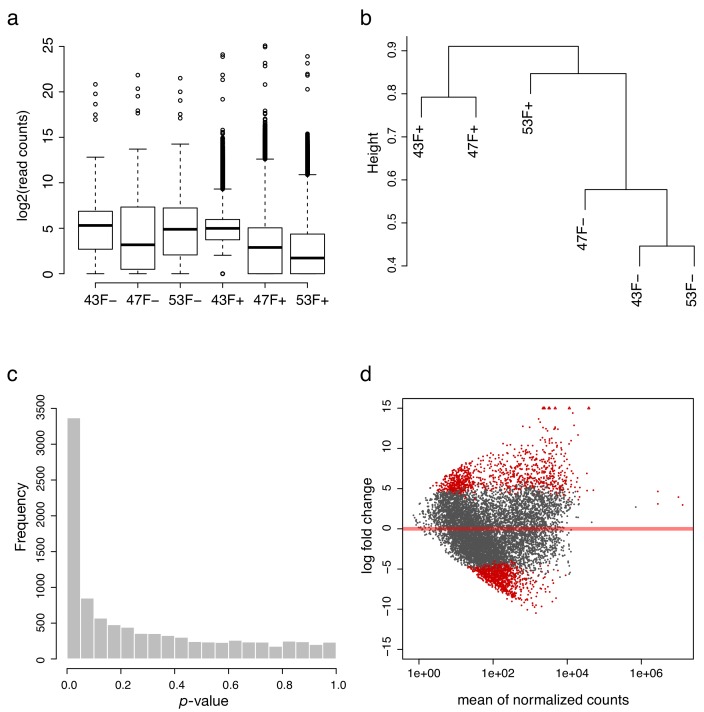
Quality control of human nuclear Probe-Seq RNA sequencing.(a) Log2-transformed read distribution plot for sequenced human GRM6 Probe-Seq samples. (b) Dendrogram of read counts shows clustering of GRM6- and GRM6+ samples. (c) Plot of frequencies of p-values shows an even distribution of null p-values. (d) MA plot of log2 fold change vs. mean of normalized counts. Red dots indicate genes that are differentially expressed between GRM6+ and GRM6- samples.